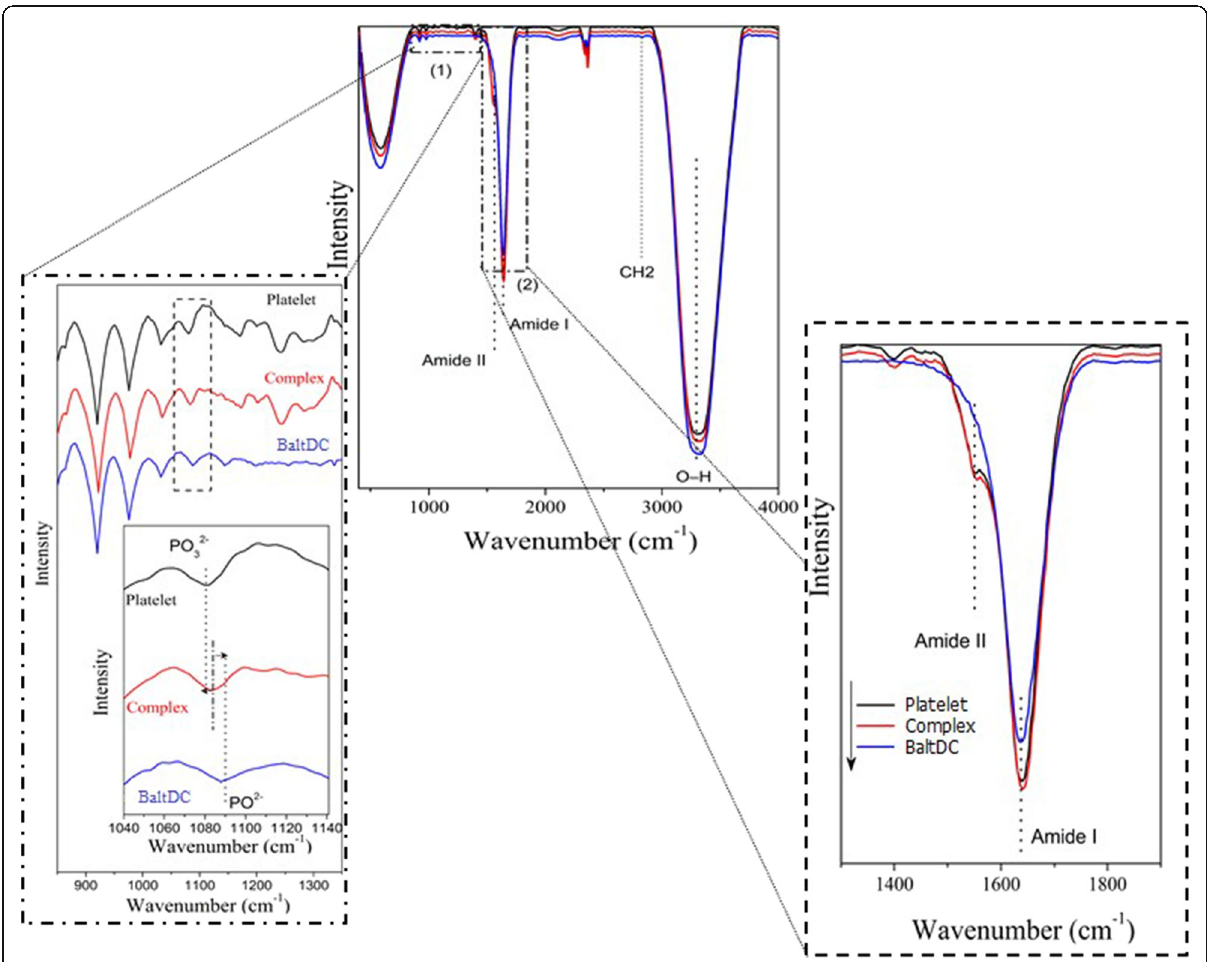
Fig. 4 FT-IR Spectra of BaltDC, platelet and complex (BaltDC/platelet). Zoom 1:850 – 1350 cm − 1 . Zoom 2: 1300 – 1900 cm − 1 . IR spectra were recorded by a total attenuated reflectance element coupled (ATR) with resolution of 2 cm −